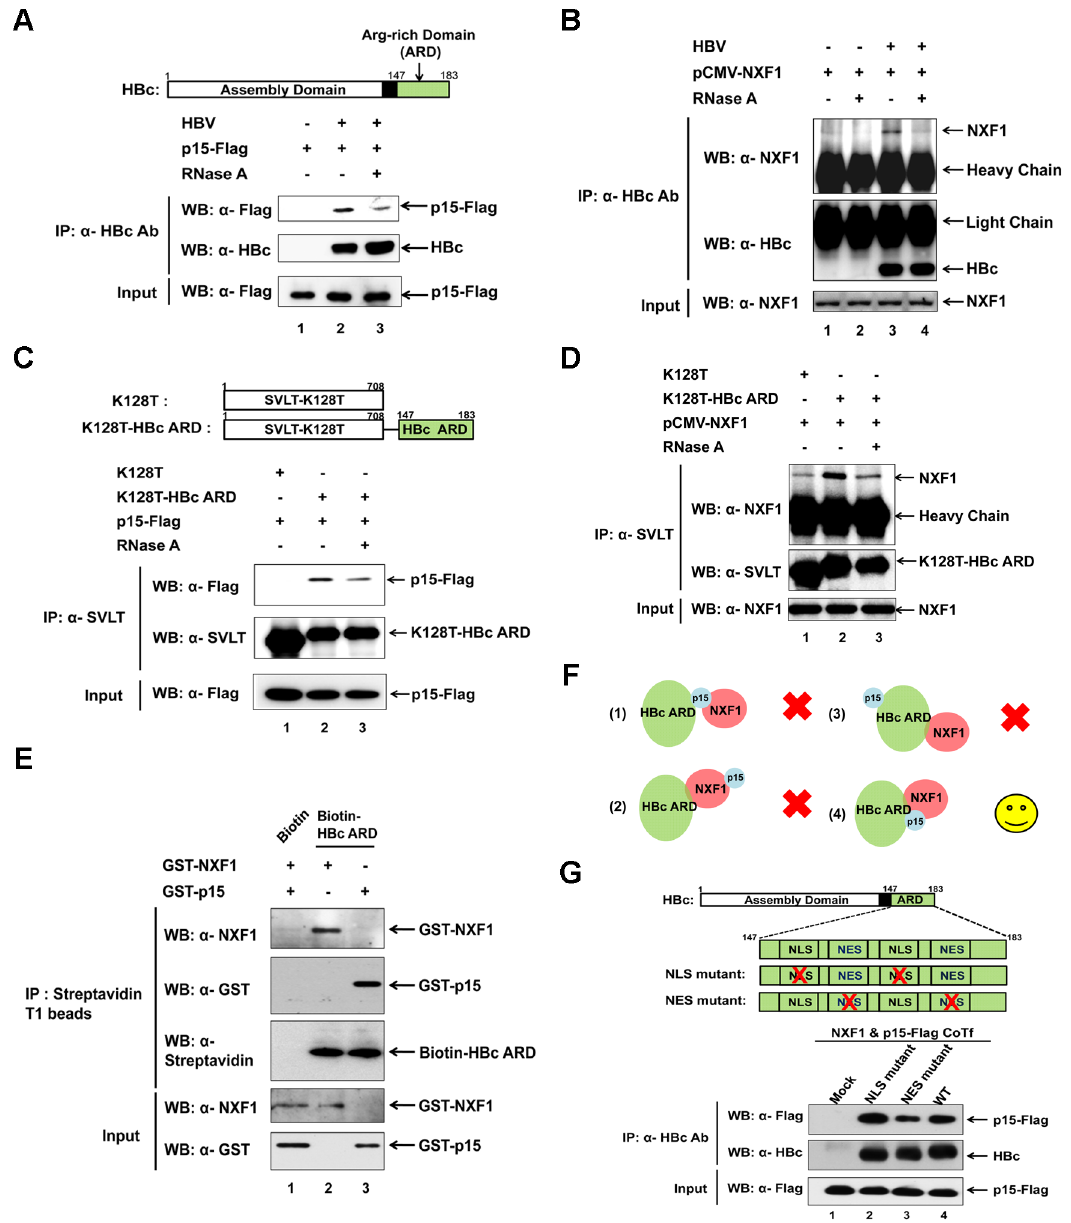
Figure 2. HBV core protein (HBc) can physically and specifically associate with the cellular NXF1-p15 complex via the NES (nuclear export signal) motif of HBc arginine rich domain (ARD). A) Upper panel : Full-length HBc (HBc 183) consists of a capsid assembly domain and an arginine rich domain (amino acid 147–183). Lower panel: HuH-7 cells were co-transfected with an HBV genome and a p15-Flag expression vector. Full-length HBc 183 protein can physically and specifically associate with a p15-Flag protein in a ribonuclease (RNase)-sensitive manner by coimmunoprecipitation assay (co-IP) and Western blot analysis (WB). B) Full-length HBc 183 protein was shown to associate with the native exogenous NXF1 protein by the same co-IP assay as described above. C) The upper panel shows a schematic outline of a K128T-HBc ARD chimera construct. The rationale of the experimental design is as detailed in the text. The co-IP result here demonstrated that only the chimera protein K128T- HBc ARD, but not K128T, can physically associate with the p15-Flag protein. D) By the same co-IP assay, only the chimera protein K128T-HBc ARD can physically associate with the native exogenous NXF1 in an RNase sensitive manner. E) Biotin-HBc ARD synthetic polypeptide can in vitro pull down purified recombinant proteins of GST-NXF1 and GST-p15 by using streptavidin T1 beads (Materials and Methods). F) A cartoon illustrates that either NXF1 or p15 can bind directly to HBc ARD. Possibility 3 refers to a situation when NXF1 and p15 do not form heterodimer even at high concentrations. The results in Fig. 2E support for possibility 4. G) Upper panel: A schematic outline of the mapped NLS and NES of HBc ARD [26]. Lower panel: HuH-7 cells were co-transfected (CoTf) with plasmid DNAs of NXF1 and p15-Flag expression vectors, and a mutant HBV genome containing R- to-A mutations at HBc NES or NLS subdomains. This NES mutant HBc exhibited significantly decreased physical association with the p15 protein (compare lane 3 with lanes 2 and 4). Ablation of the two NLS motifs appeared to increase slightly the intensity of p15-Flag (compare lane 2 and 4), suggesting that the wild type NLS could have a moderate occlusion effect on the association between p15-Flag and their neighboring NES.